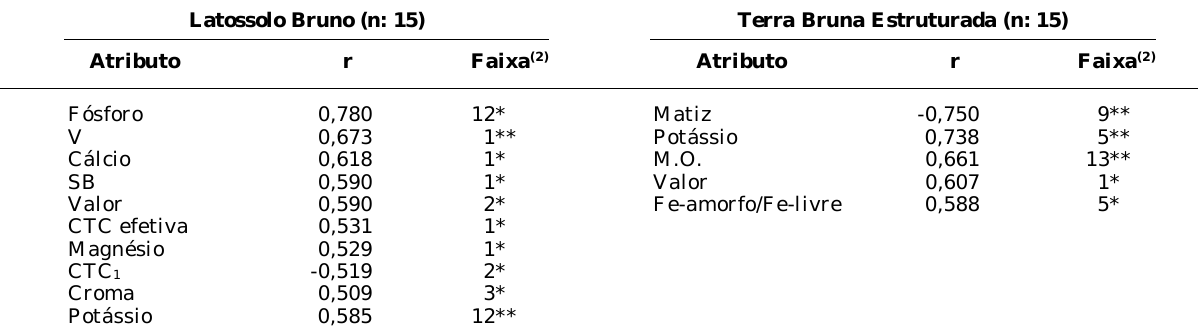
Quadro 4. Faixas de comprimento de onda que apresentaram coeficientes de correlação mais elevados com os atributos (1) dos solos (As amostras do Latossolo Bruno e da Terra Bruna Estruturada foram consideradas